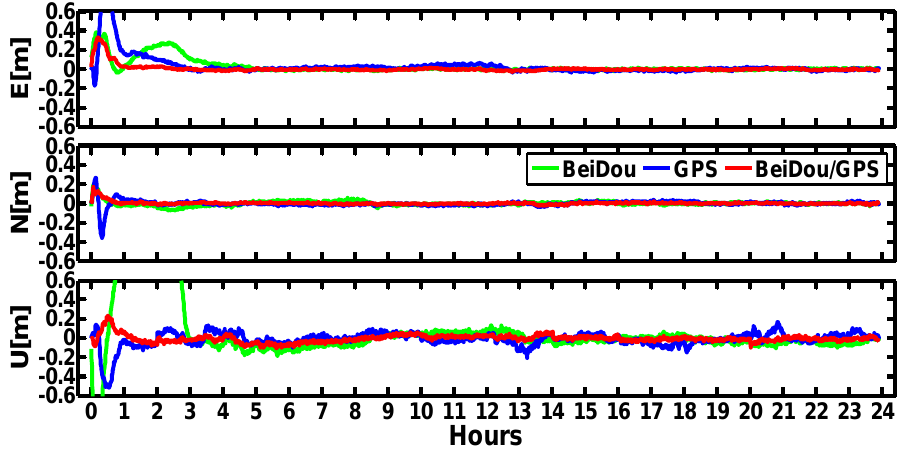
Figure 8. Differences between BeiDou, GPS, and BeiDou/GPS kinematic PPP solutions with respect to the “ground truth” in the East, North and Up components of CHDU station, respectively on September 24, 2012.